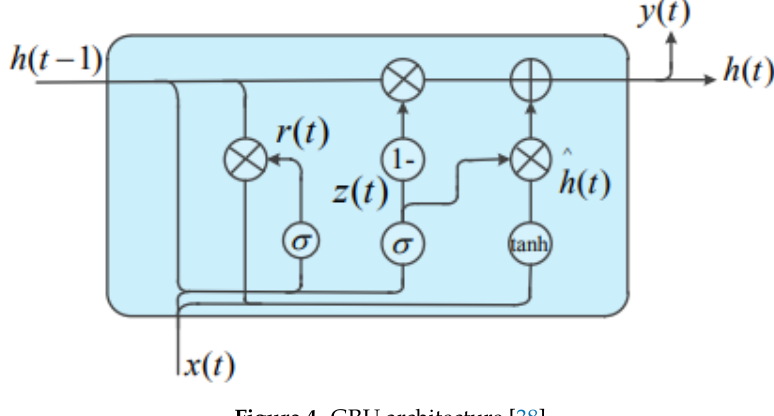
Figure 4. GRU architecture [38].